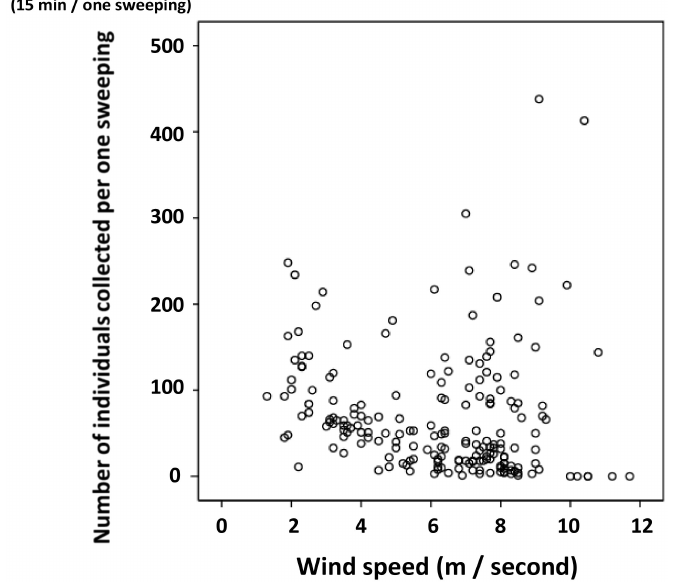
Figure 6. The relationship of the number of individual oceanic skaters to wind speed during collection. (Pearson’s correlation analysis: n = 195, r = − 0.116, p =